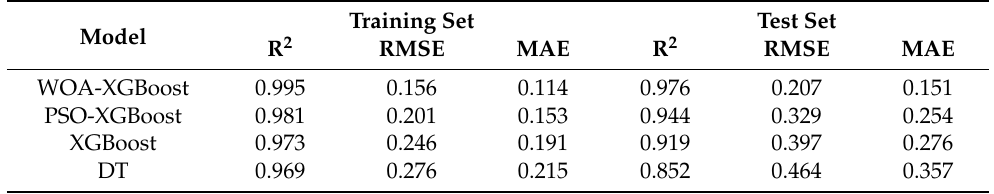
Table 5. Performance indexes of WOA-XGBoost model, PSO-XGBoost model, XGBoost model, and DT